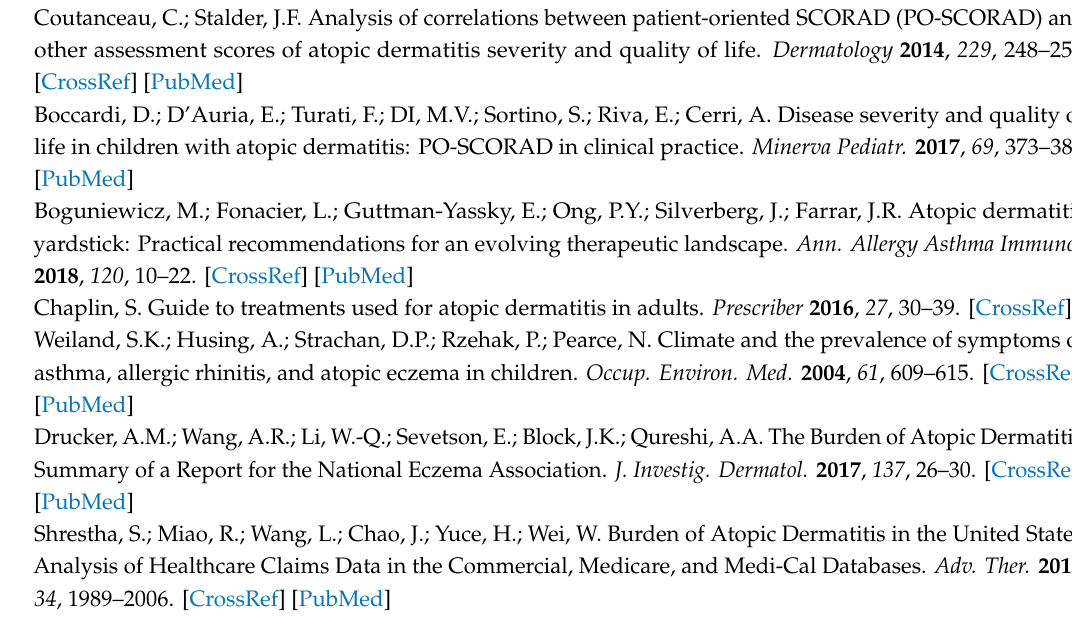
Figure S1: Funnel Plot for meta-analysis of serum 25(OH)D levels in Atopic Dermatitis population compared with healthy controls (nmol / L), Figure S2: Funnel Plot of comparison of serum 25(OH)D levels in adult and paediatric Atopic Dermatitis population (nmol / L) versus their age-matched healthy controls, with sub-analysis by age group, Figure S3: Forest Plot for sub-analysis of vitamin D intervention trials in Atopic Dermatitis based on vitamin D dosage and time period, Table S1: Quality analysis of included observational studies using the Newcastle-Ottawa Scale, Table S2: Quality Analysis of included Interventional Studies using Cochrane Risk of Bias Scale, Table S3: Sensitivity Analysis of Meta-analysis of comparison of Serum 25(OH)D levels of AD vs. NonAD with each study exclusion, Table S4: Sensitivity analysis of Meta-analysis of comparison of Serum 25(OH)D levels of AD vs. Non-AD excluding studies from common regions and ethnicities, Table S5: Sensitivity Analysis of RCT Intervention trials of VitD supplementation in Atopic